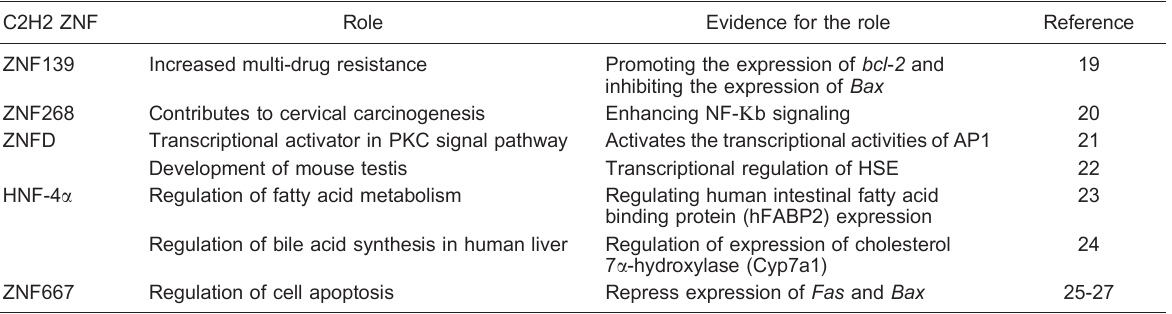
Table 1. Role of C2H2